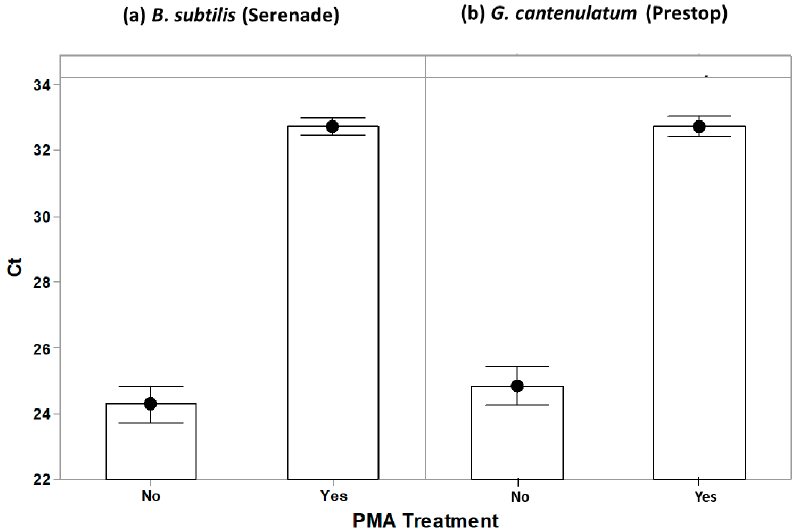
Figure 2. Effect of PMAxx™ on blocking DNA amplification from dead BCA cells for ( a ) B. subtilis and ( b ) G. cantenulatum . The black circular points show the mean of six replicates for the non-PMA treatment, and the mean of 24 replicates for the PMA treatment. Each replicate was carried out in triplicate on the qPCR plate. The bars represent the standard error of the means.